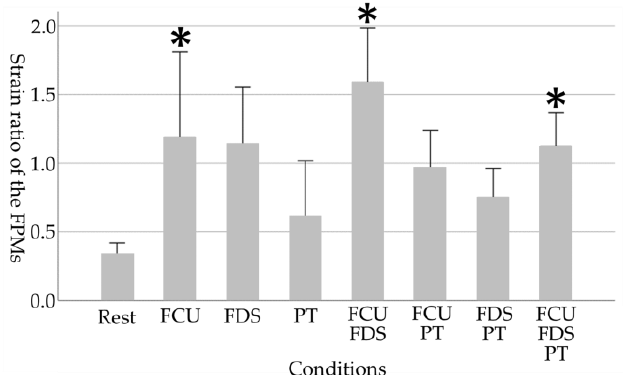
Figure 5. Changes in FPMs due to selective contraction of the FPMs. A higher value in strain ratio indicates harder (stiffer) tissue. Asterisks indicate significant differences compared to the resting condition ( p < 0.05). Error bars in the graph are standard errors. FPMs, forearm flexor–pronator muscles; FCU, flexor carpi ulnaris; FDS, flexor digitorum superficialis; PT, pronator teres.